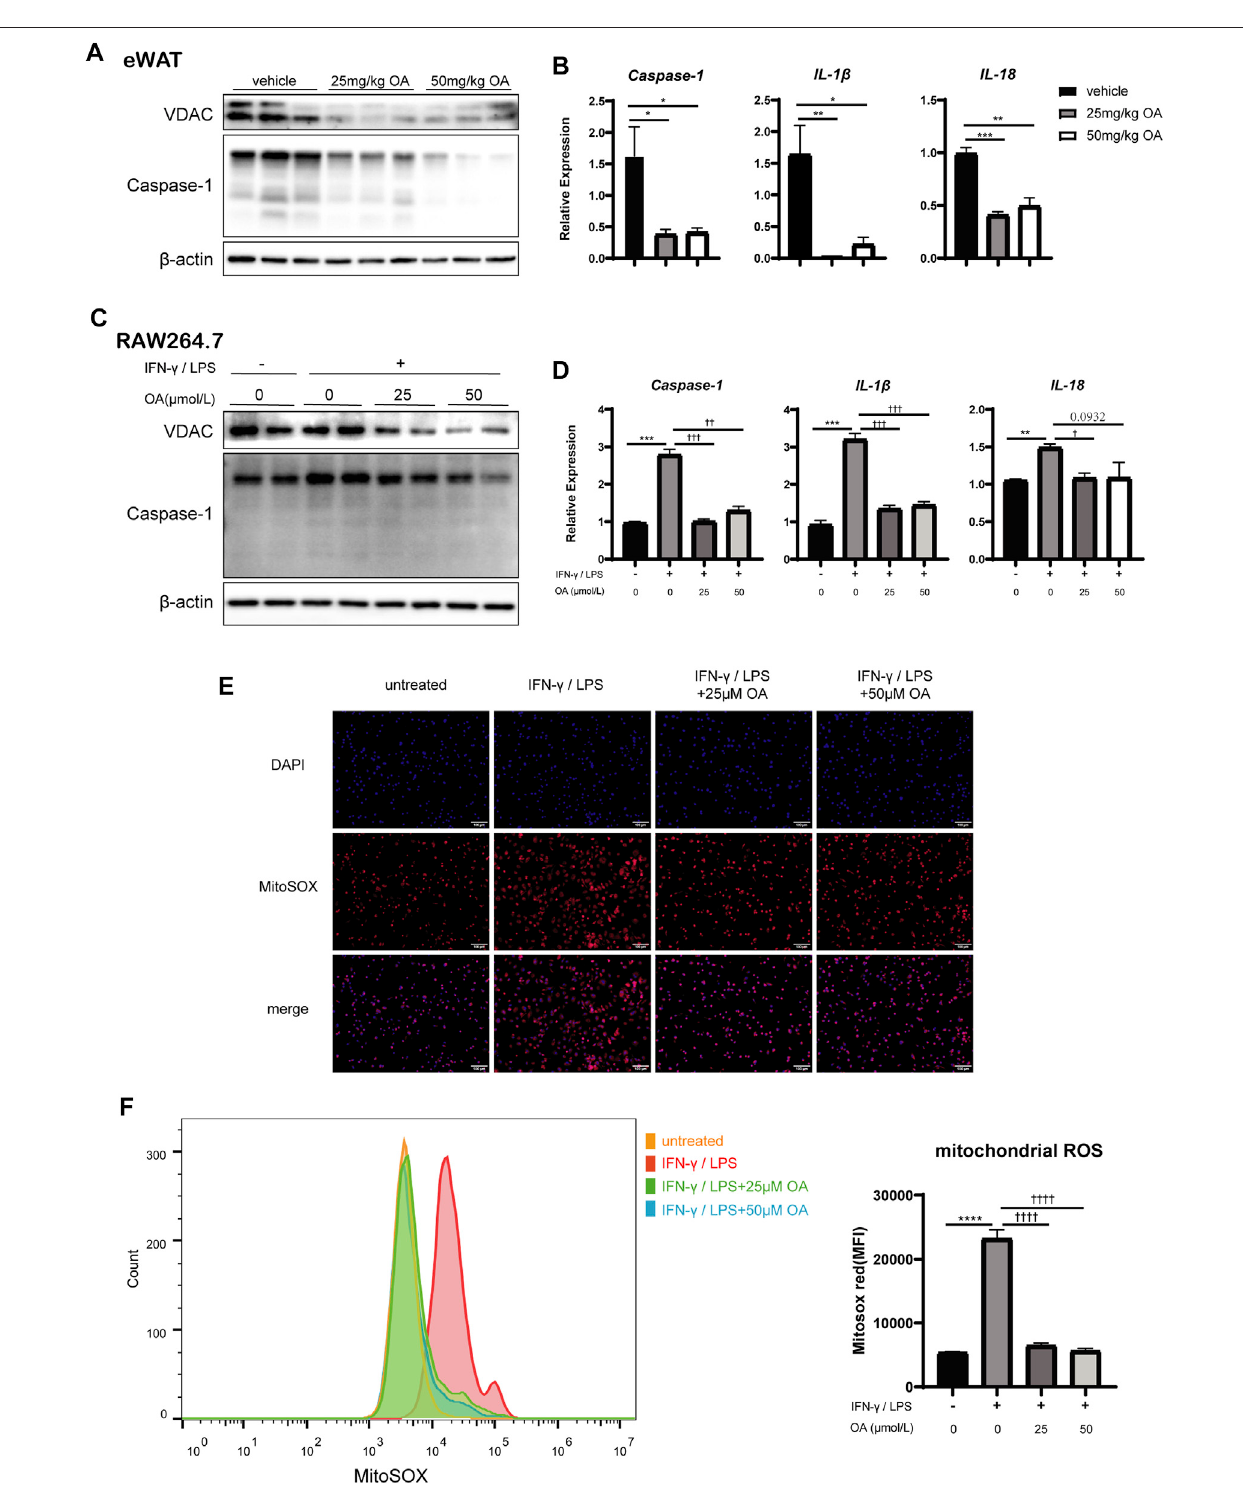
FIGURE5| OAdecreases theexpressionofVDAC,theactivationofNLRP3in fl ammasomeandtheproductionofmitochondrialROS invitro and/or invivo . (A) WB ofVDAC,Caspase-1,IL-1 β ineWATofmice. (B) qPCRresultsofCaspase-1,IL-1 β andIL-18ineWAT( n (cid:1) 5). (C) WBofVDAC,Caspase-1inRAW264.7macrophages. (D) qPCR results of Caspase-1, IL-1 β and IL-18 in RAW264.7 macrophages ( n (cid:1) 3). (E) Fluorescence staining of mitochondrial ROS in RAW264.7 macrophages. (F) Fluorescence intensity ofMitoSOX analyzed byFCM inRAW264.7 macrophages( n (cid:1) 3 – 4). * p < 0.05, ** p < 0.01, *** p < 0.001, **** p < 0.0001 vs. vehicleor control incubations, † p < 0.05, †† p < 0.01, ††† p < 0.001, †††† p < 0.0001 vs. IFN- γ /LPS stimulated incubations.